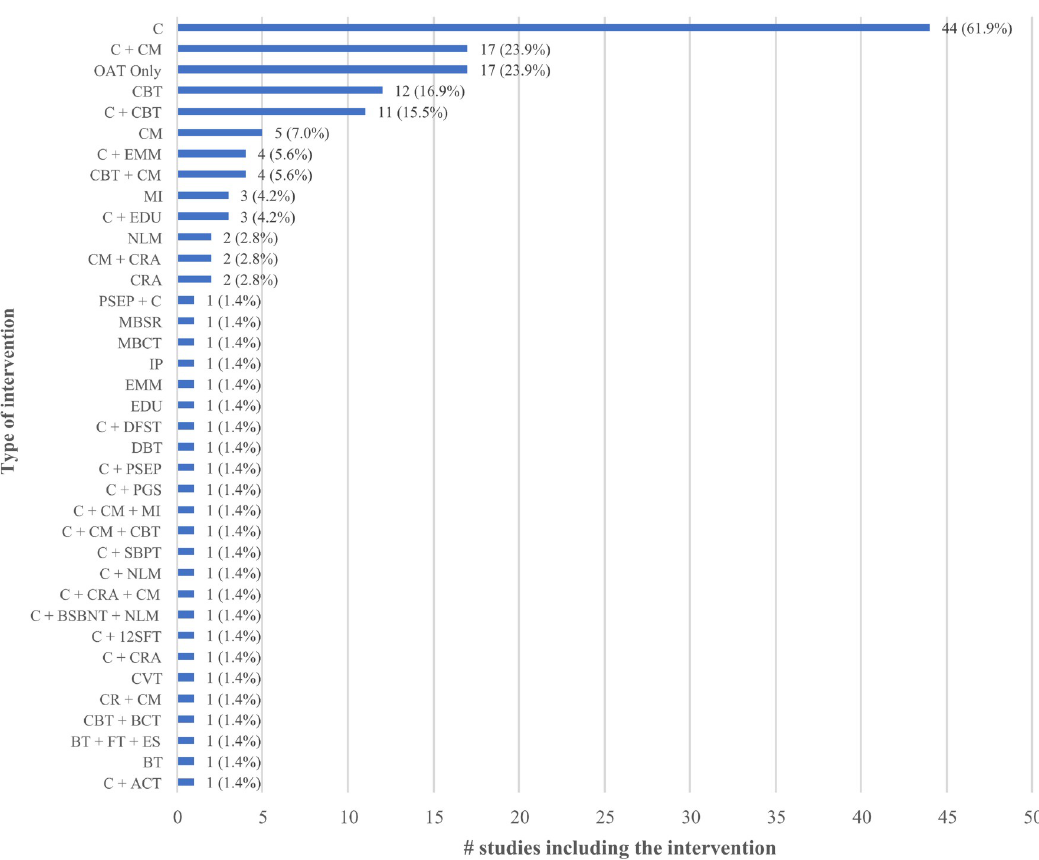
Fig 2. Type of psychosocial interventions. The number and type of different psychosocial interventions that were assessed across the set of included studies is